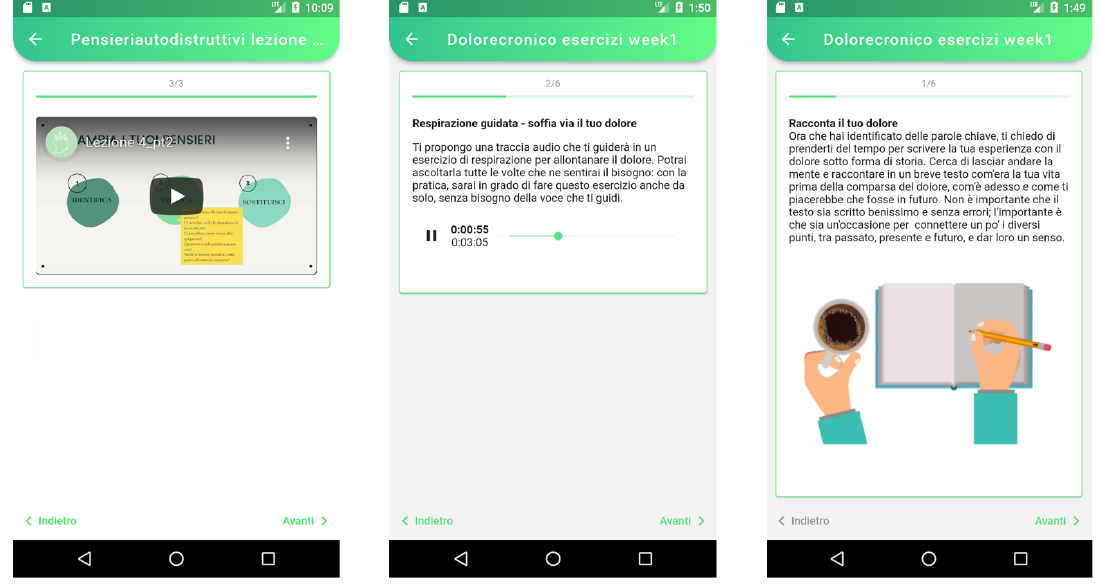
Figure 3. Screenshot of an example of psychoeducational video and exercises .